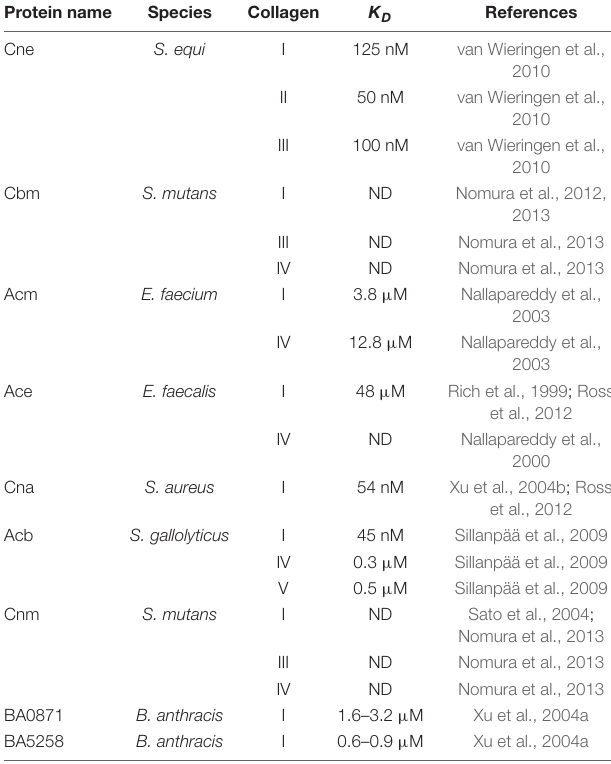
TABLE 2 | Collagen binding CNA-like